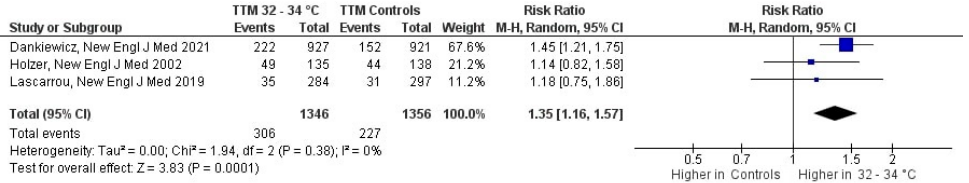
Figure 4. Forest plot of arrhythmias in patients resuscitated after cardiac arrest. Comparison is made between patients according to the strategy of target temperature management (TTM). CI: confidence interval, M-H: Mantel-Haenszel.